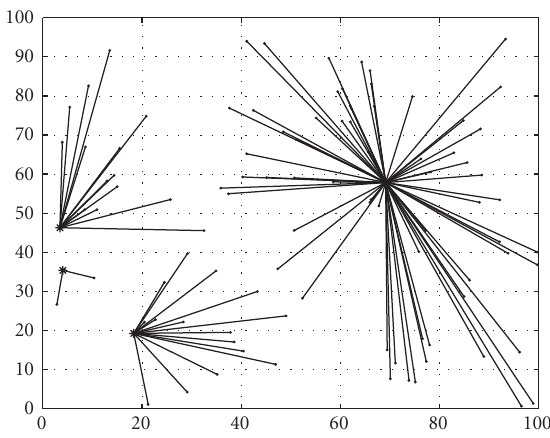
Figure 5: The clustering structure for using